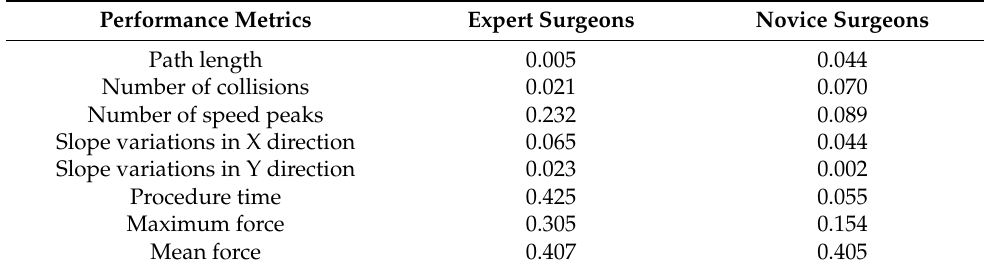
Table 1. The significance of the differences between the manipulation data for each indicator obtained from the same skill group at different vascular difficulty levels ( p -value).